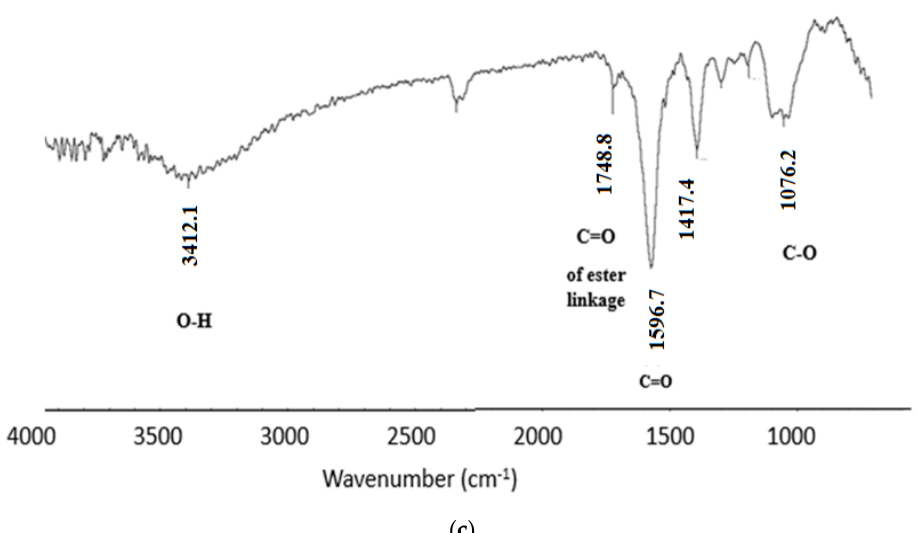
Figure 4. FTIR spectra of ( a ) OISW. ( b ) carboxymethylated OISW, and ( c ) thermally cured carboxymethylated OISW (CMOISW).